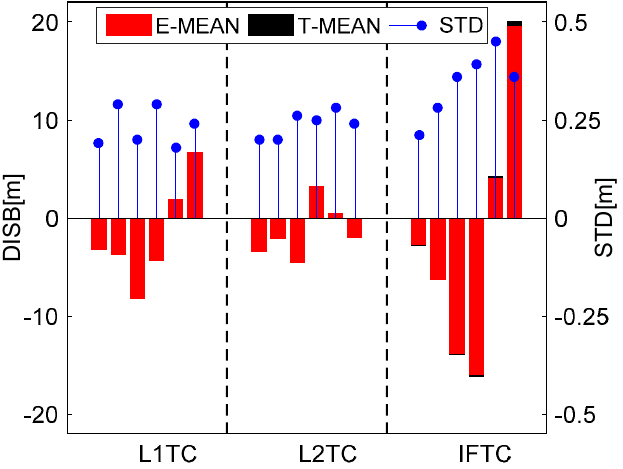
solution. The standard deviations of the single-epoch results for the three receiver pairs are also at the level of a few decimeters. The standard deviation of the ISB becomes smaller with increasing epochs. The precision of the ISB for some receiver pairs can reach a few centimeters within 50 epochs. In this case, the sizes of the ISB in the IFTC method for RC4, RC5, and RC6 are − 16.01 m, 4.15 m, and 19.62 m, respectively [2].